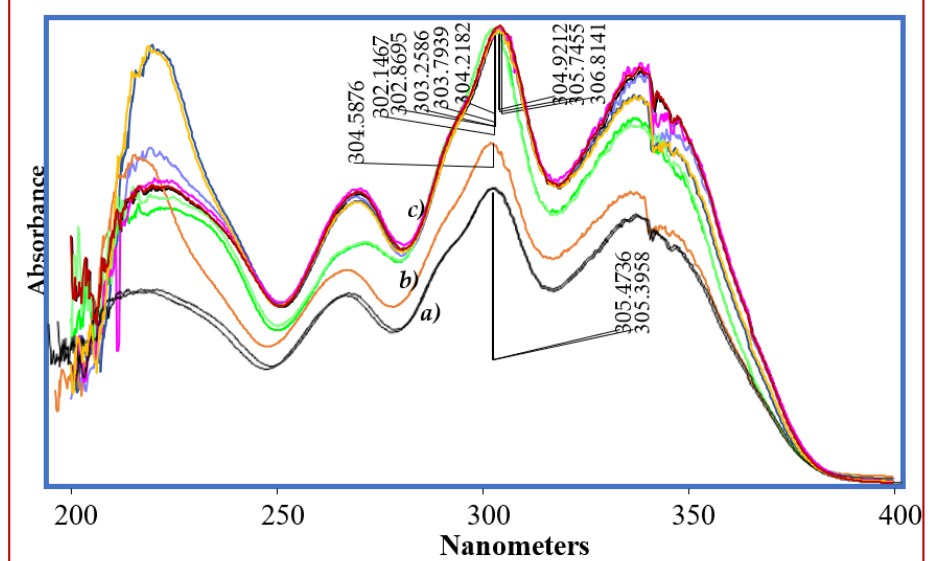
Figure 4. UV absorbance spectrum of VEL, IMPs and DPs.